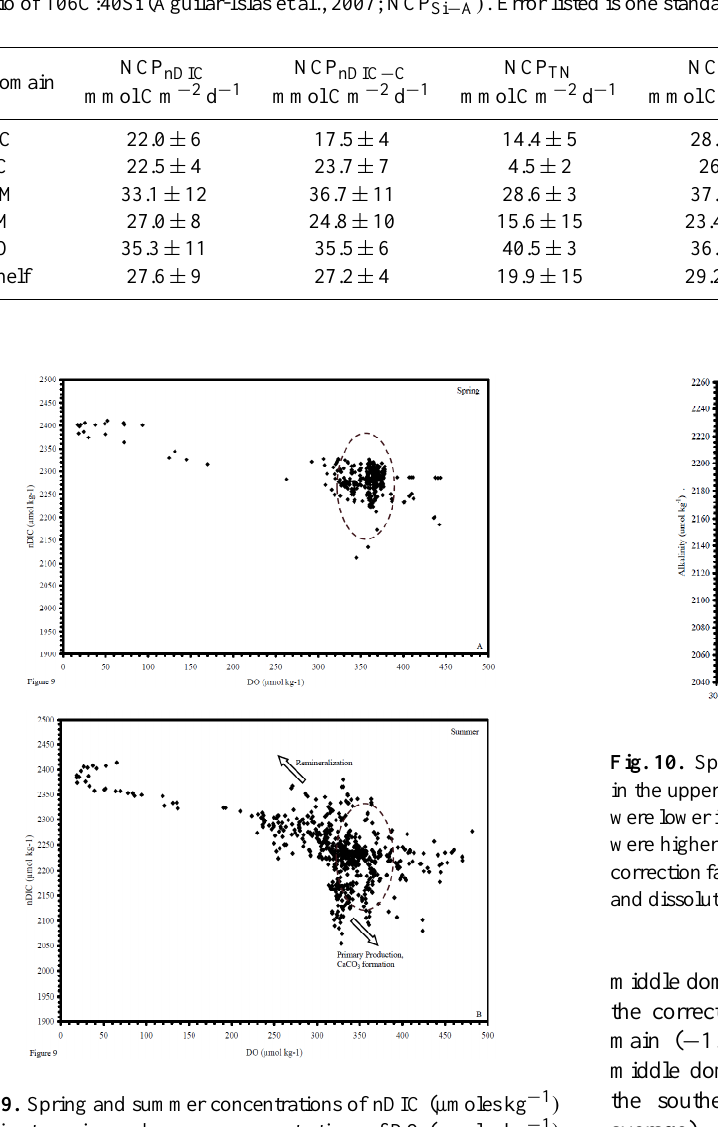
Fig. 9. Spring and summer concentrations of nDIC (µmoleskg − 1 ) relative to spring and summer concentrations of DO (µmoleskg − 1 ) (A) Spring. Most points clustered within the highlighted area of DO concentrations between 300 and 400µmoleskg − 1 , and DIC con- centrations between ∼ 2200 and 2450µmoleskg − 1 . (B) Summer. DIC concentrations were much less clustered and mostly lower rel- ative to DO concentrations in spring. For ease of comparison, the springtime cluster is also shown in this figure (highlighted area). The arrows show the effects of primary production and carbonate mineral dynamics between station occupations: NCP draws values down and to the right, as surface layer DIC is consumed and DO is produced; remineralization draws values up and to the left as DIC is produced and DO is consumed.